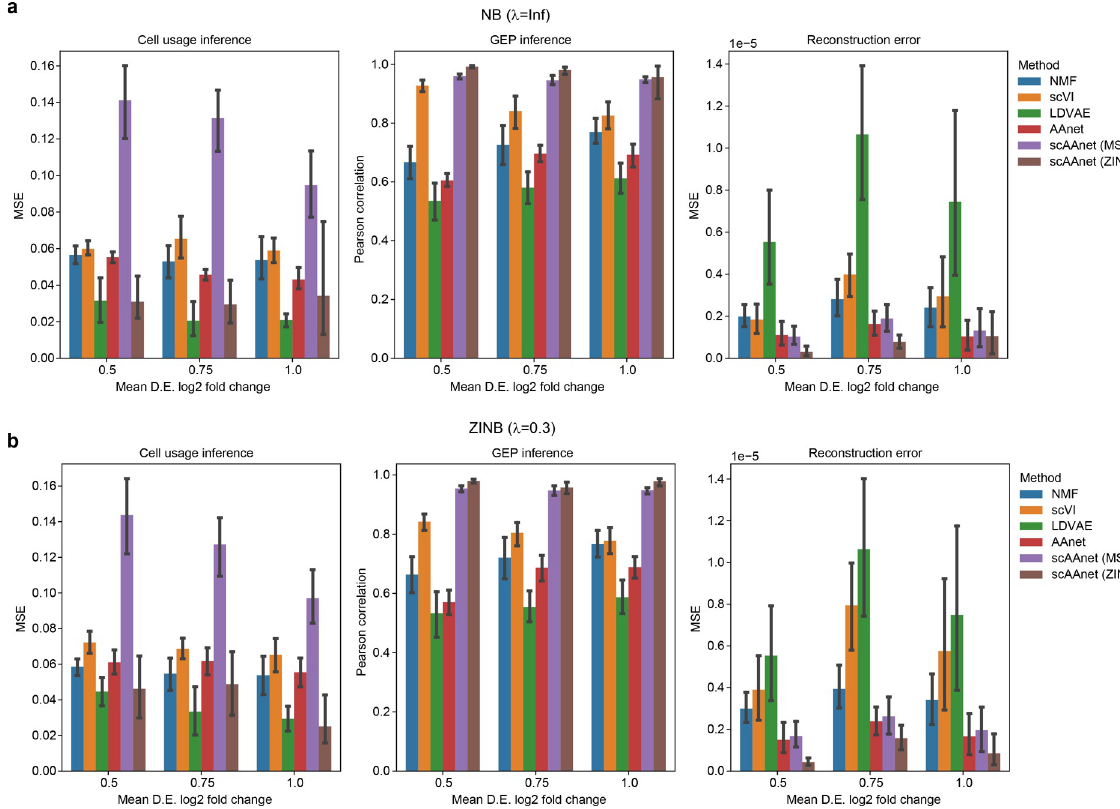
Fig 2. Performance of scAAnet and other methods on simulated scRNA-seq datasets. (a) Results from datasets that were simulated under NB distributions. Figures from left to right are MSE between inferred cell usages and true usages of the 4 GEPs, Pearson correlation between inferred GEPs and true GEPs, and MSE between reconstructed scaled means and true means. (b) Similar results from datasets that were simulated under the ZINB distribution ( λ = 0.3). Error bars around the means were drawn with 95% confidence interval. D.E.: differential